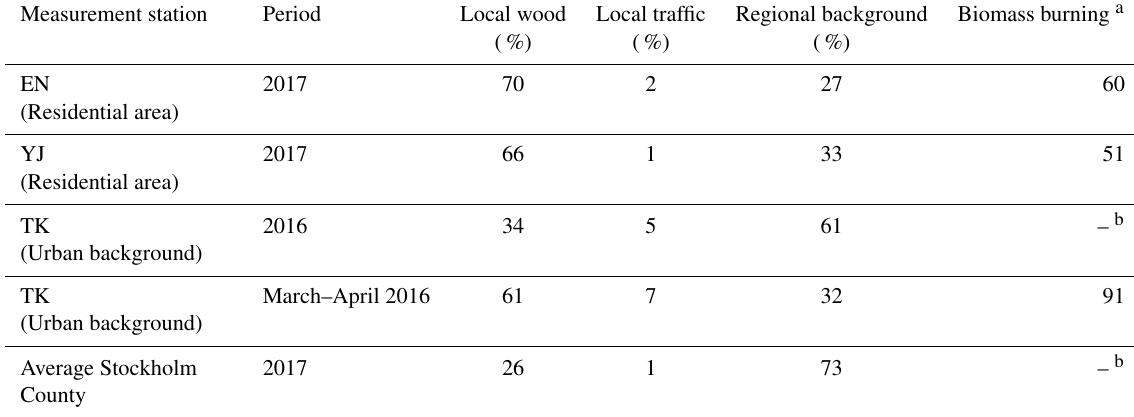
Table 2. Calculated percentage contribution from local and non-local sources to B[ a ]P. Measurement station